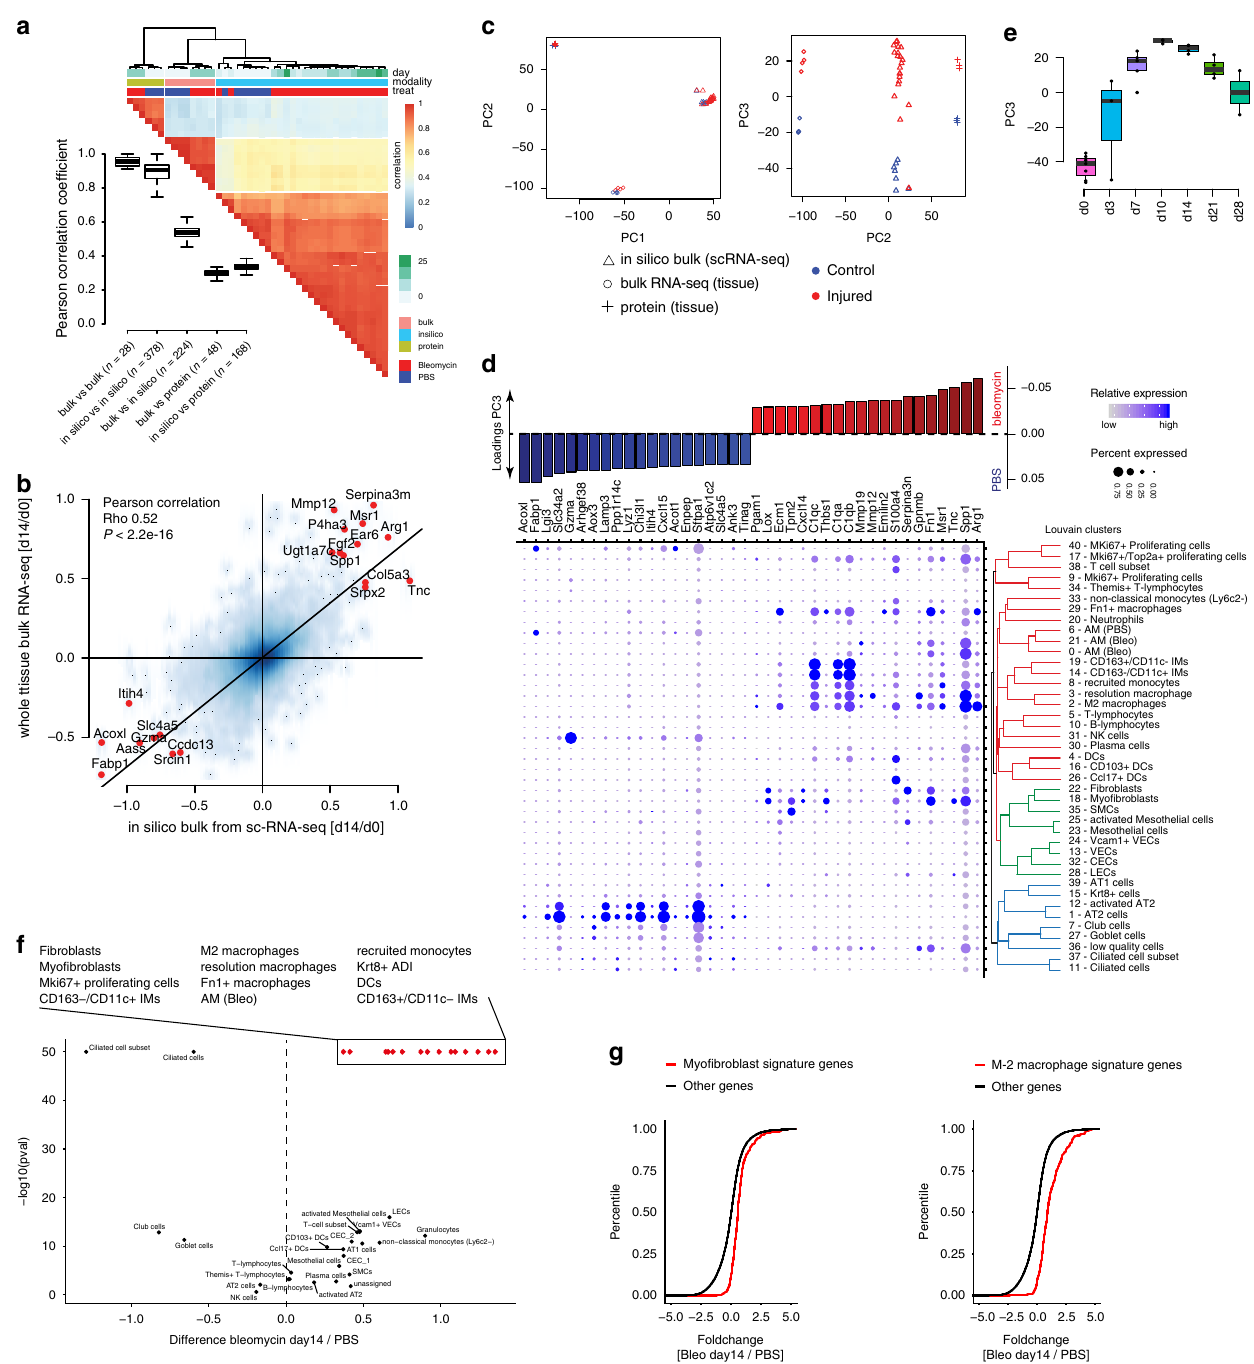
resolution we sorted EpCam + cells and sampled single cell transcriptomes daily up to day 13. We also included later time points up to day 54 after injury to analyze the recovery of the system back to baseline with fully regenerated AT1 cells. In total, we collected 18 time points after injury using two replicate mice each ( n = 36 mice; k = 34575 cells) (Fig. 4a). Cell type identities were consistent with the fi rst whole-lung experiment and we identi fi ed rare neuroendocrine cells and basal cells in addition (Fig. 4b; Supplementary Fig. 7). We observed gene expression changes of AT2 cells with cell state densities moving towards the Krt8 + ADI state already at early time points starting at day 2 (Fig. 4d). A continued presence of Krt8 +